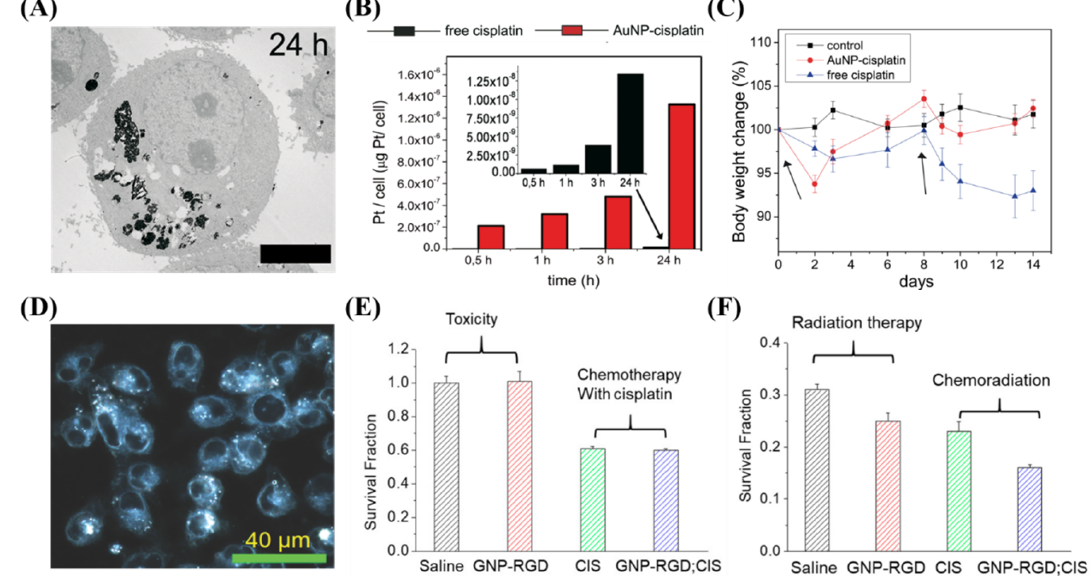
Figure 7. Cisplatin and gold nanoparticles . ( A – C ) Cisplatin conjugated GNPs lead to an increased deposition of platinum into A549 cells compared to the free drug in vitro, which led to less side effects in vivo with similar efficacy. Scale bar is 4 µm. ( D – F ) The use of free cisplatin to synergize with GNPs in a chemoradiation modality in vitro lead to a synergistic effect. Scale bar is 40 µm. Reprinted with permission from [116,147] . Copyright 2012 Public Library of Science. Copyright 2018